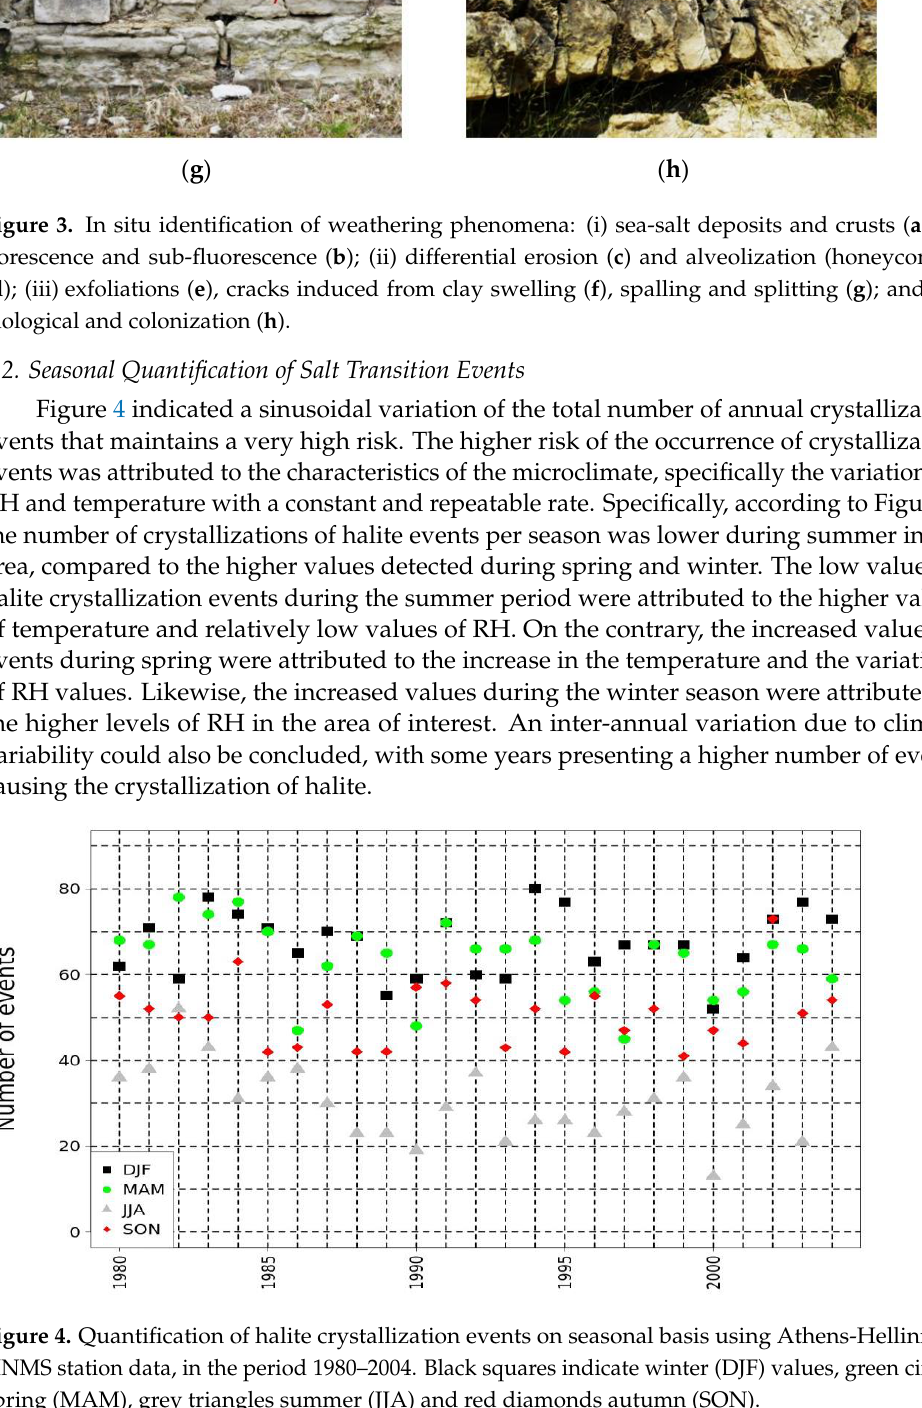
Figure 5. X-ray diffraction patterns of the seven untreated natural stone samples, indicating the presence of calcite ( C ), dolomite ( D ), quartz ( Q ), albite ( A ), illite ( I ), kaolinite/montmorillonite ( K/M ) and halite ( H ). Specifically, S_01 was a whitish marly limestone with coherent micritic structure, rich in ooids, with intergranural and vuggy porosity. S_02 was a pale yellow marly limestone with coherent micritic structure, characterized by the presence of intergranural and vuggy porosity, along with moldic porosity (secondary porosity). It was characterized by the presence of salts on the superficial layers and by the presence of cracks. S_03 was a yellowish marly limestone with micritic structure, presenting intrafossil pores (intragranural porosity) and moldic porosity, in addition to intergranural and vuggy porosity. Calcite veins were also detected and attributed to the presence of the phenomena of differential erosion. S_04 was a pale yellow marly limestone with coherent micritic structure, presenting intrafossil pores (intragranural porosity), in addition to intergranural and vuggy porosity. The matrix of S_03 and S_04 was characterized by the enhanced presence of ooids and benthic foraminifera. S_05 and S_06 were whitish marly limestones with coherent micritic structure, characterized macroscopically by the presence of extended yellowish layers composed of clay minerals